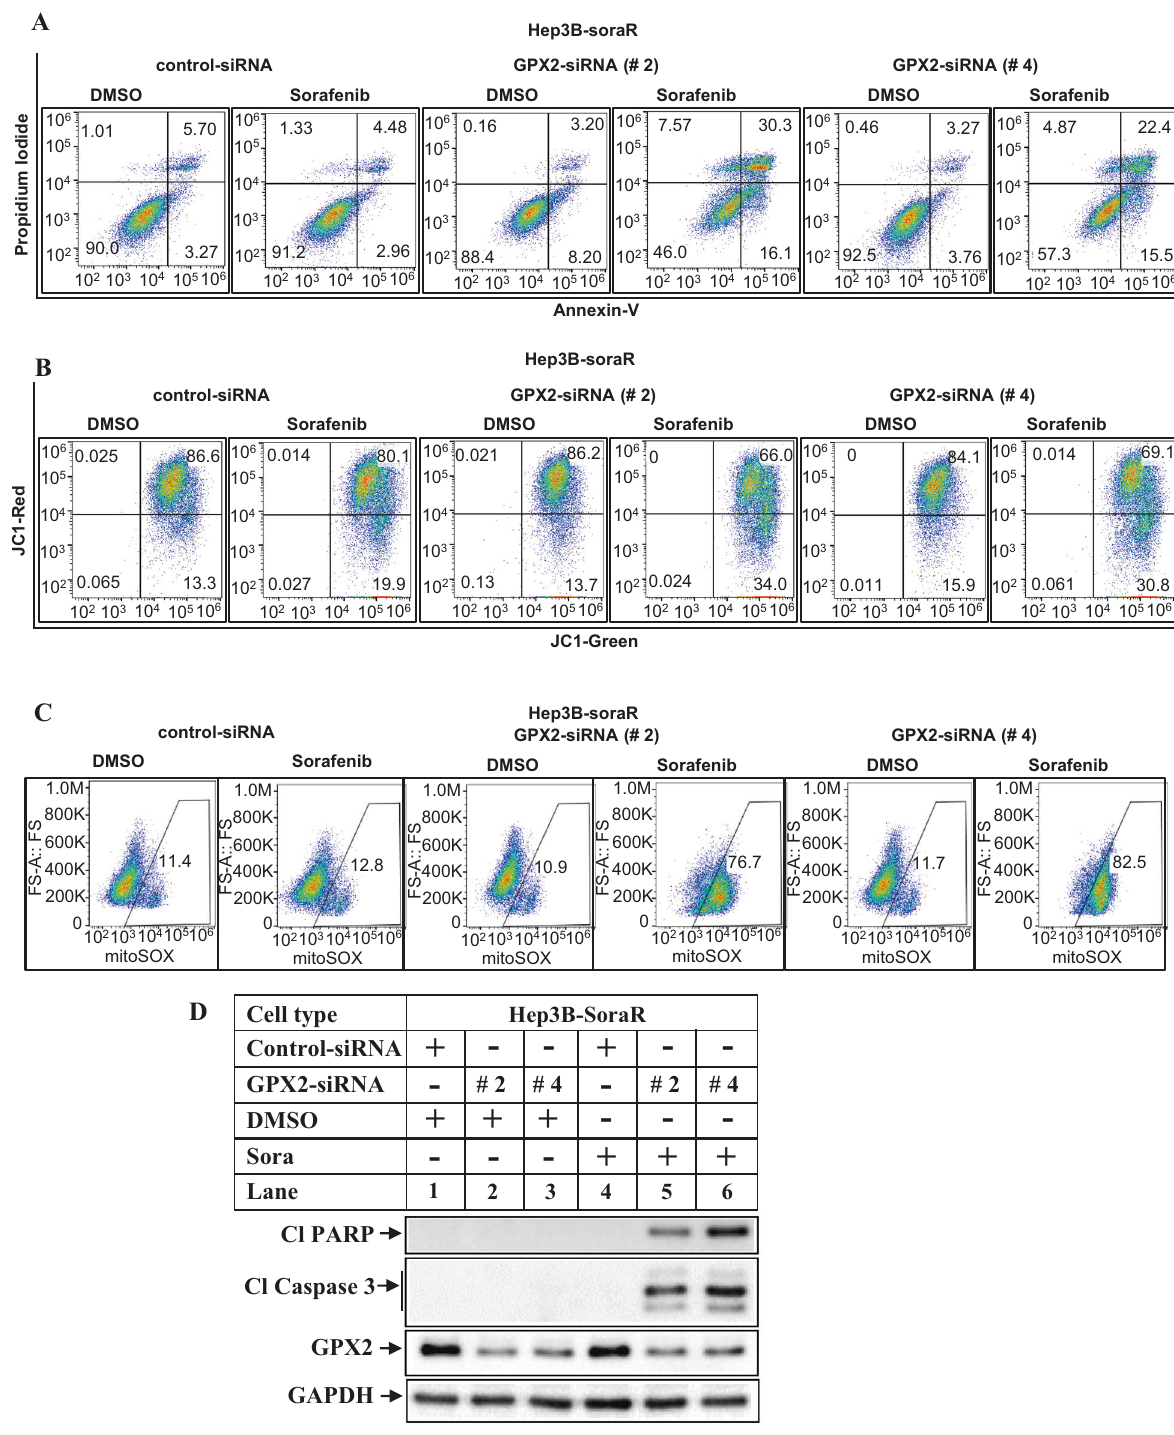
Fig. 8 Ets-1/GPX2 axis regulates sorafenib resistance. Hep3B-soraR cells were transfected with control-siRNA or two different GPX2-siRNA (#2, #4) and treated with DMSO or sorafenib for 48 h followed by fl ow cytometry to detect apoptosis ( A ), mitochondrial damage ( B ), or mROS ( C ). D Hep3B-soraR cells transfected and treated as in A were analyzed by western blots with the indicated antibodies. Cl PARP cleaved PARP, Cl Caspase 3 cleaved caspase 3. expression of cleaved PARP and cleaved caspase 3 were highly B), siRNA #2 and #4 showed maximal suppression. Interestingly, elevated with GPX2 knockdown and sorafenib treatment in the knocking down GPX2 by either siRNA #2 or #4 signi fi cantly soraR cells (Fig. 8D). These suggest that GPX2 functions as a increased sorafenib sensitivity of the soraR cells as indicated by downstream target of Ets-1 and plays a crucial role in maintaining increased apoptosis (Figs. 8A and S8A), mitochondrial damage sorafenib resistance. (Figs. 8B and S8B), and mROS (Figs. 8C and S8C). Moreover, the Cell Death and Disease (2022)